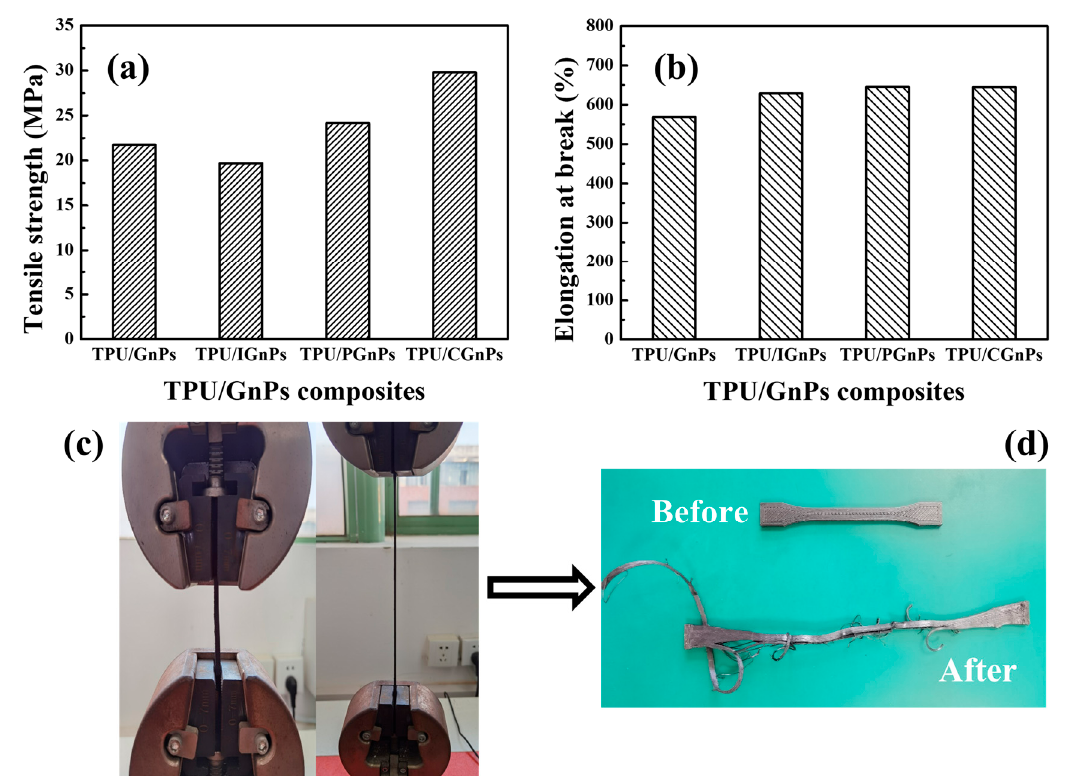
Figure 5. ( a ) Tensile strength and ( b ) elongation at break of various TPU/GnPs composites, ( c ) the deformed FDM parts at various stages and ( d ) the FDM-printed specimens before and after break. Table 2. Mean value and standard deviation of the dimensional deviation and surface